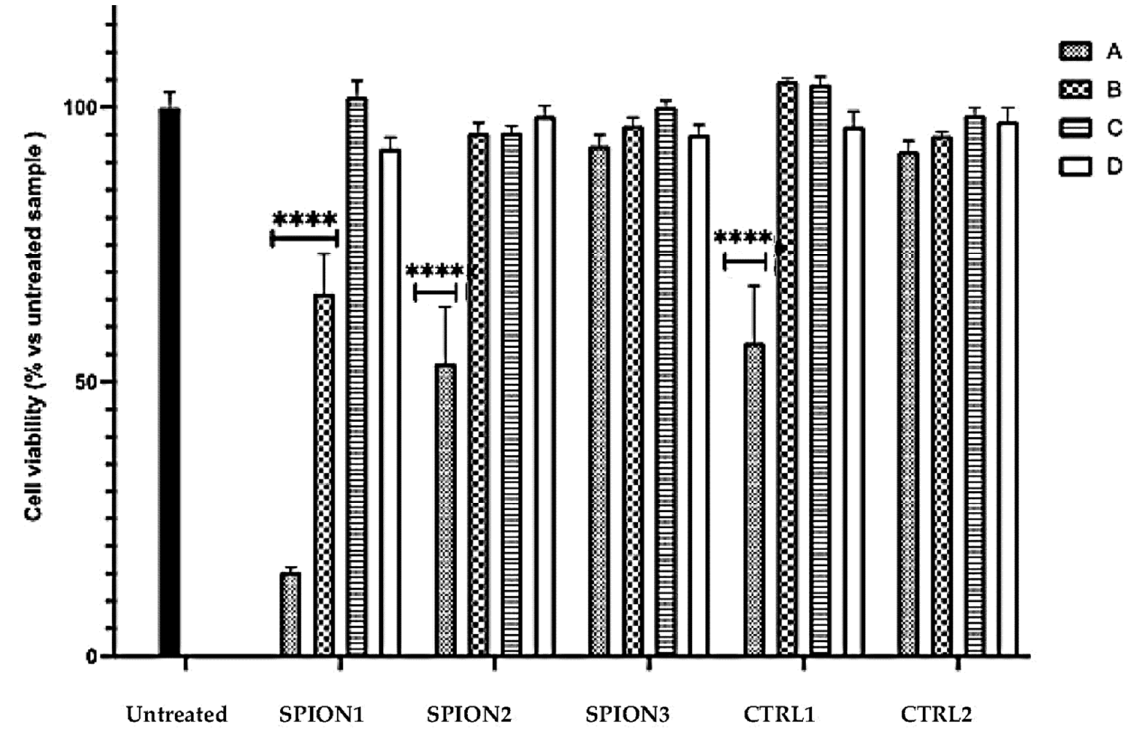
Figure 4. Cell viability assay of HeLa cells incubated with SPION1, SPION2, SPION3, CTRL1, and CTRL2 at different concentrations (i.e., A, B, C, and D respectively correspond to 50, 25, 10, and 1 µg/mL). Note: **** p < 0.0001 compared to untreated sample, n = 4 (two-way ANOVA with Dunnett’s test).